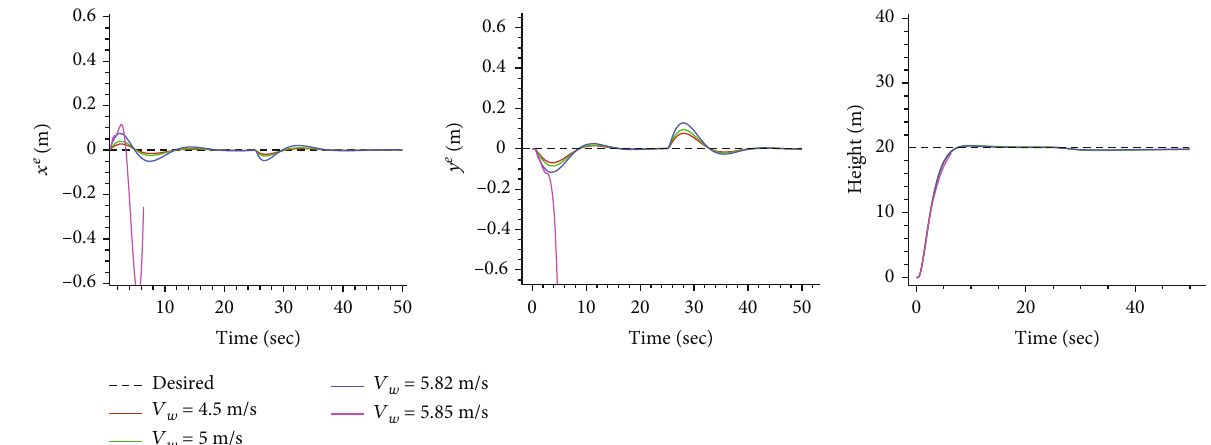
Figure 23: The position responses of the Quad-Plane under 1-cos discrete crosswind at di ff erent